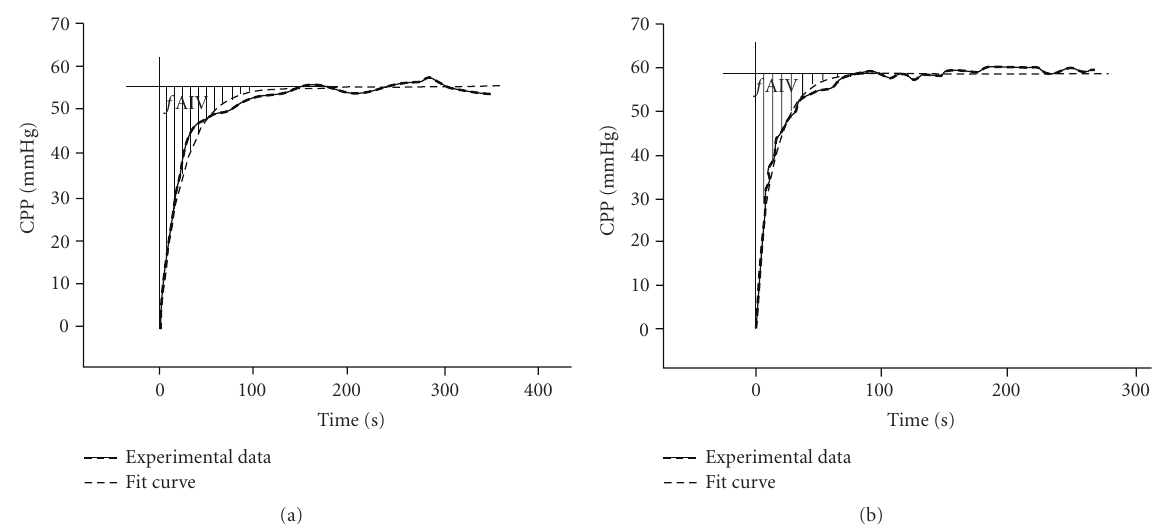
Figure 2: Restoration of CPP (original trace) in the absence (a) and in the presence (b) of glucagon ( f AIV is area of ischemic vasodilation above the fitted CPP curve).